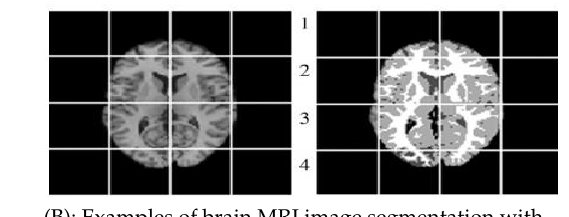
Brain tumor segmentation from MRI image using Fuzzy C-Means (FCM) algorithm: (left) Original image, (right) Results of segmentation; illustration reproduced with the permission of Taylor & Francis Ltd [50].